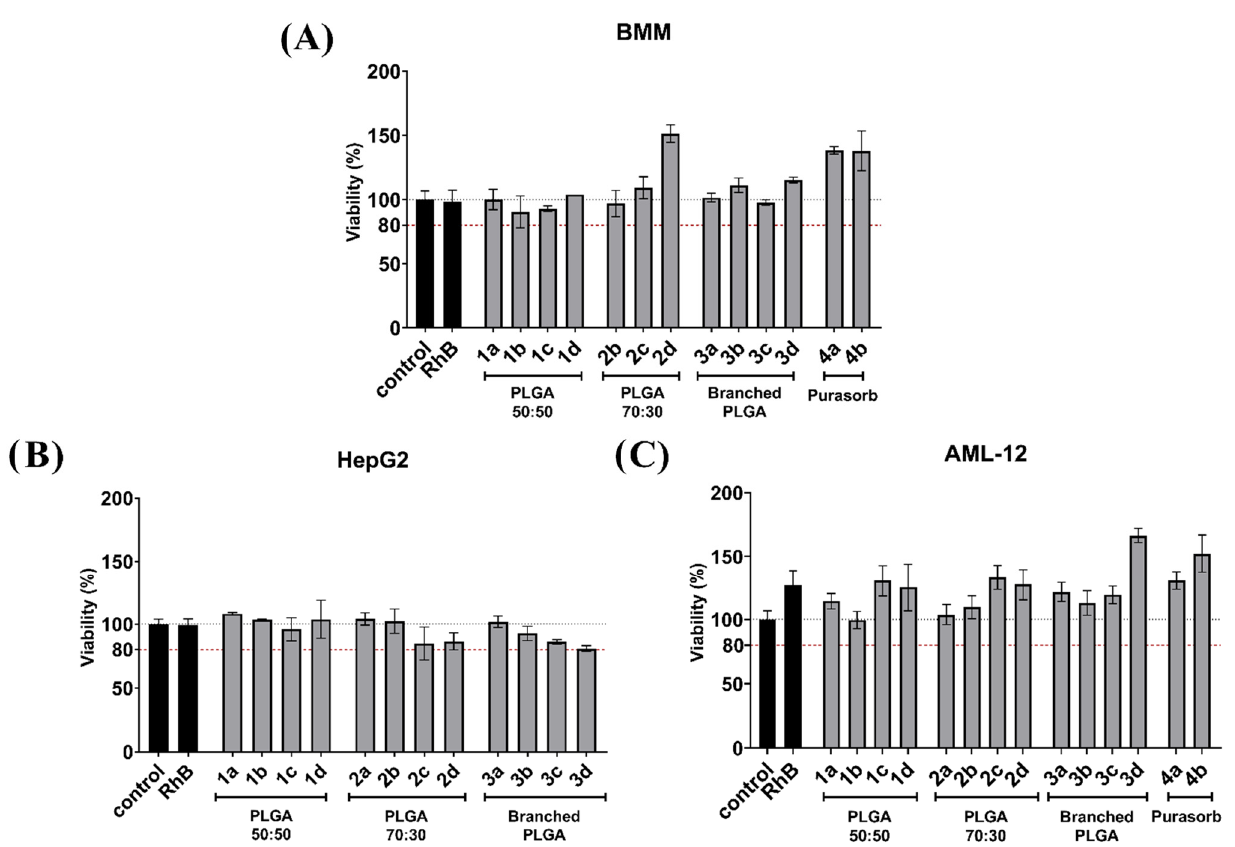
Figure 5. Viability of ( A ) bone marrow-derived macrophages (BMM), ( B ) HepG2, or ( C ) AML-12 cells after treatment with nanospheres. Cells were exposed to nanospheres for 24 h in the concentration of 300 µ g/mL and viability was evaluated by the MTS assay. Viability in cells treated with nanospheres was compared to untreated cells (control). Solution of Rhodamine B in a concentration of 15 µ g/mL (RhB) was used as the control for the model substance. A threshold of 80% viability was set as a threshold value for toxic effect.